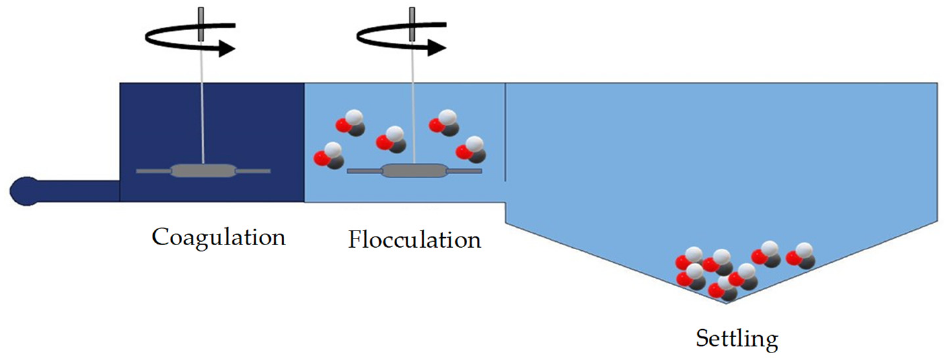
Figure 7. Coagulation, flocculation, and settling of microplastic.